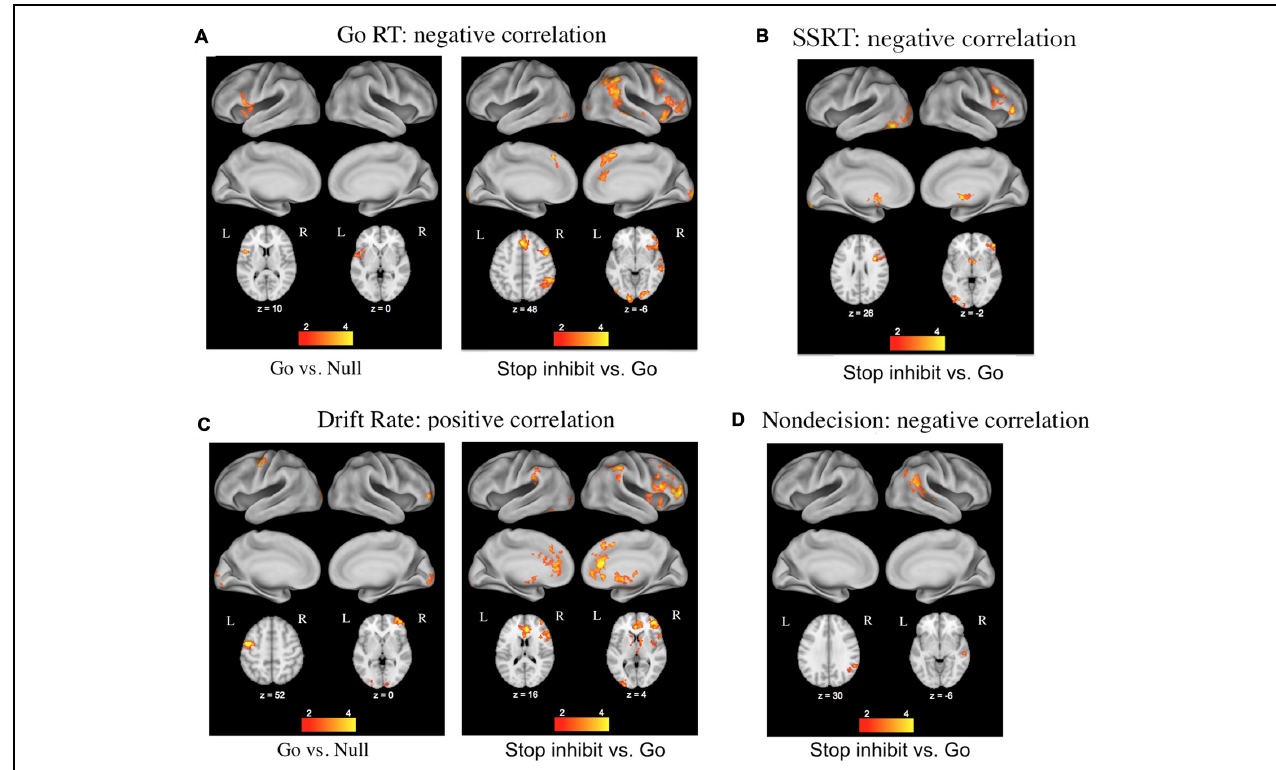
FIGURE 2 | Results of a DDM analysis of individual differences in functional magnetic resonance imaging (fMRI) activation related to performance on the stop-signal task (figure taken from White et al., 2014). (A) Correlations with mean reaction times (RTs) from go trials. (B) Correlations with stop-signal reaction times from stop trials. (C) Correlations with the DDM parameter of drift rate on go and stop trials. (D) Correlations with the DDM parameter of non-decision time on stop